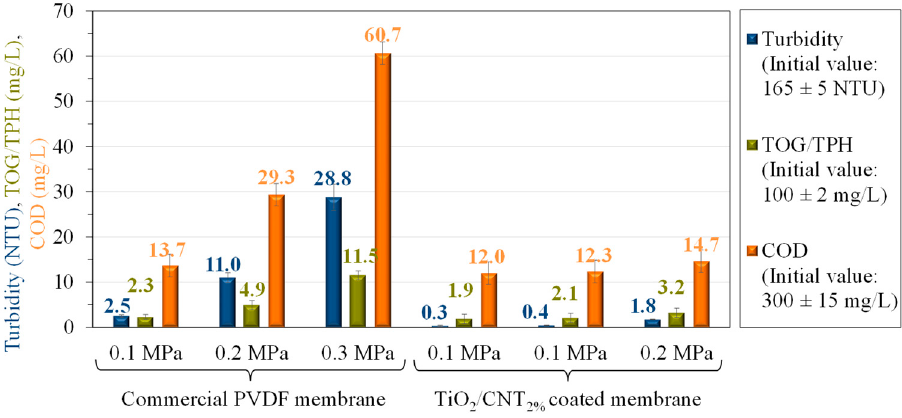
Figure 7. The turbidity, the extractable oil content (TOG/TPH), and the chemical oxygen demand (COD) of the permeates for different membranes at different transmembrane pressures.